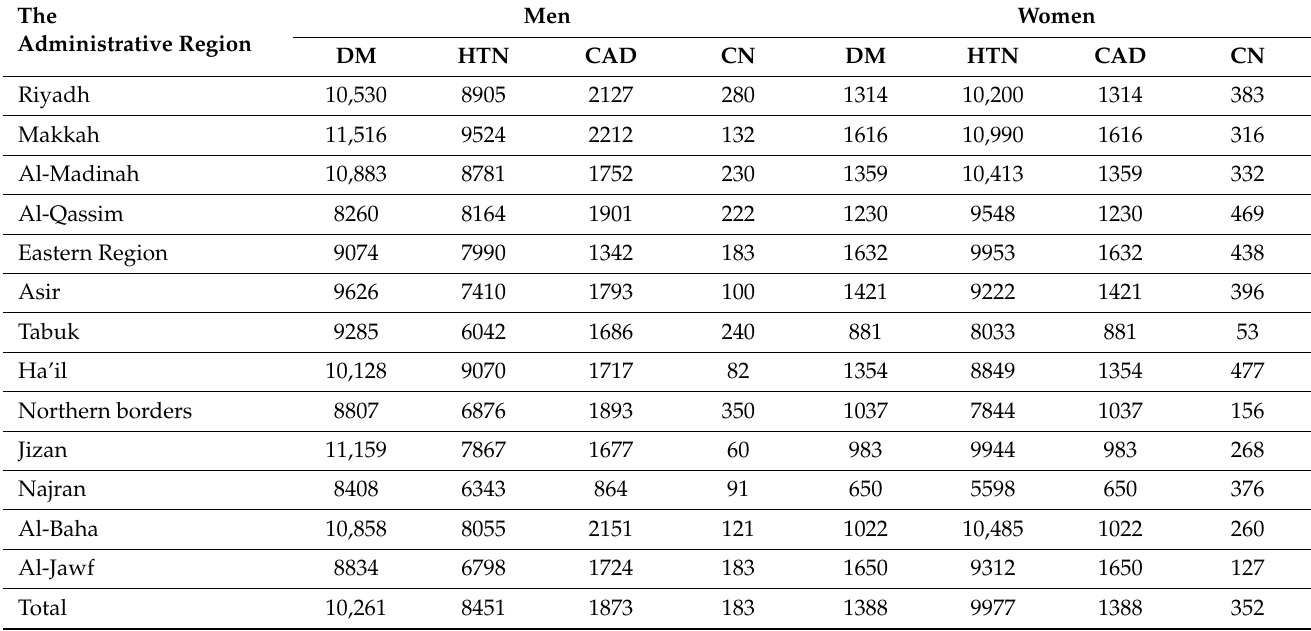
Table 3. The rates of chronic diseases in the Saudi population by gender and the administrative